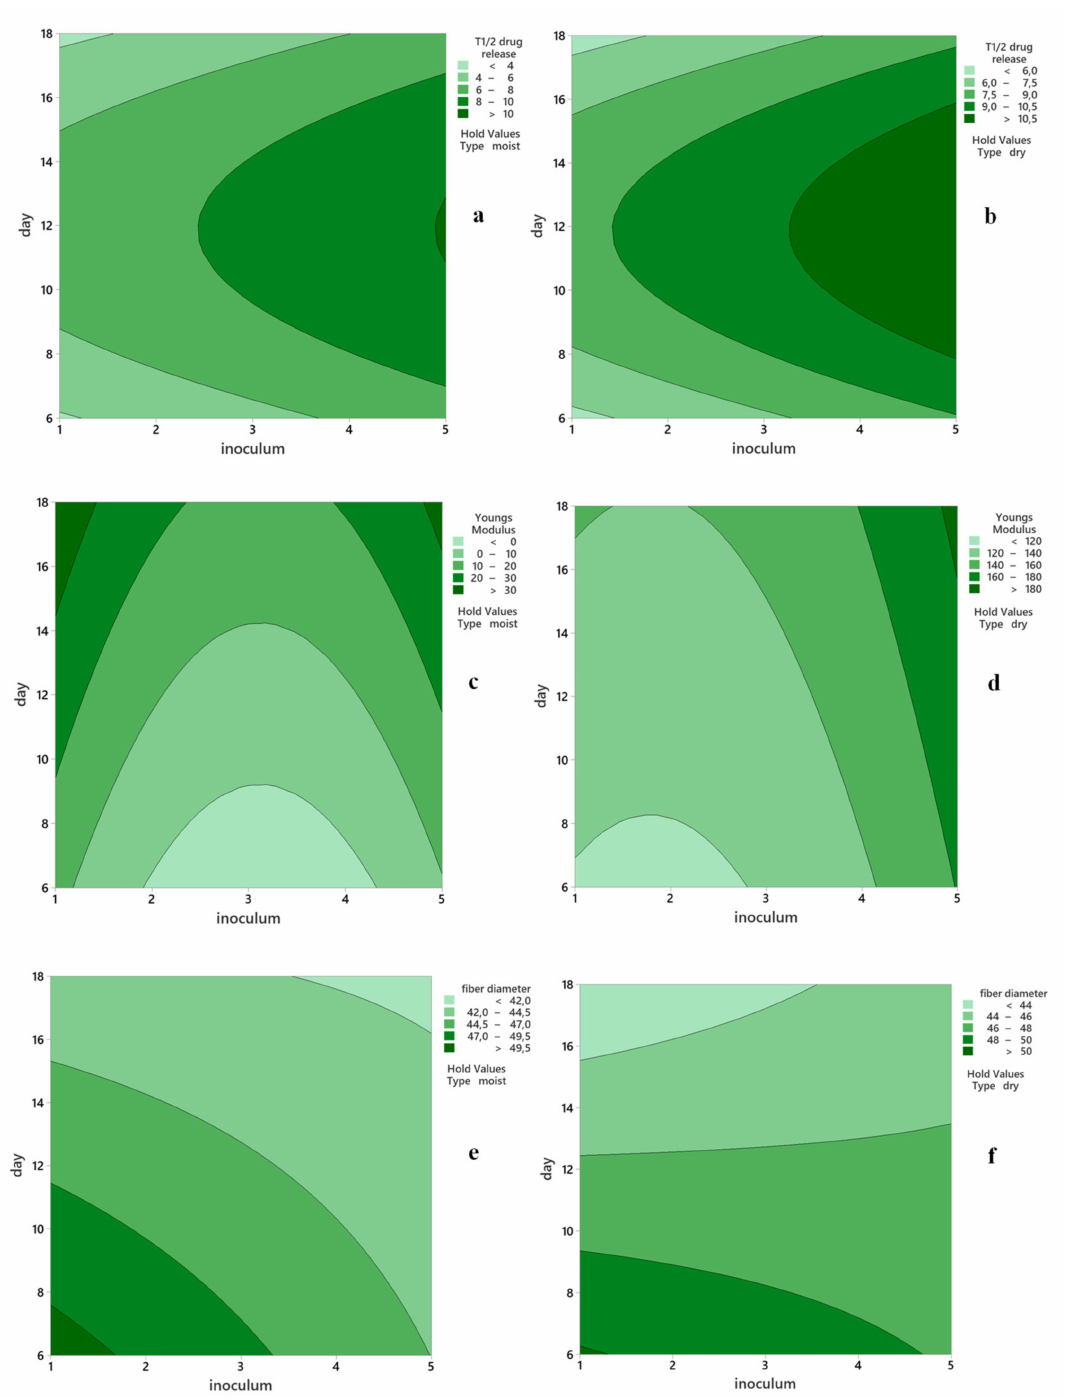
Figure 10. Response surface methodology RSM contour plots of drug half-release time of moist ( a ) and dried ( b ) bacterial cellulose (BC); Young’s modulus of moist ( c ) and dried ( d ) BC; fiber diameter of moist ( e ) and dried ( f )